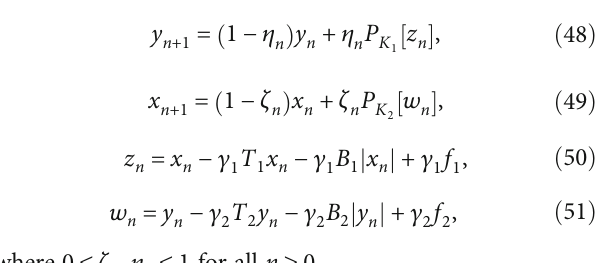
Algorithm 7. For given y 0 ∈ K 1 and x 0 ∈ K 2 , fi nd x n +1 and y n +1 by the iterative